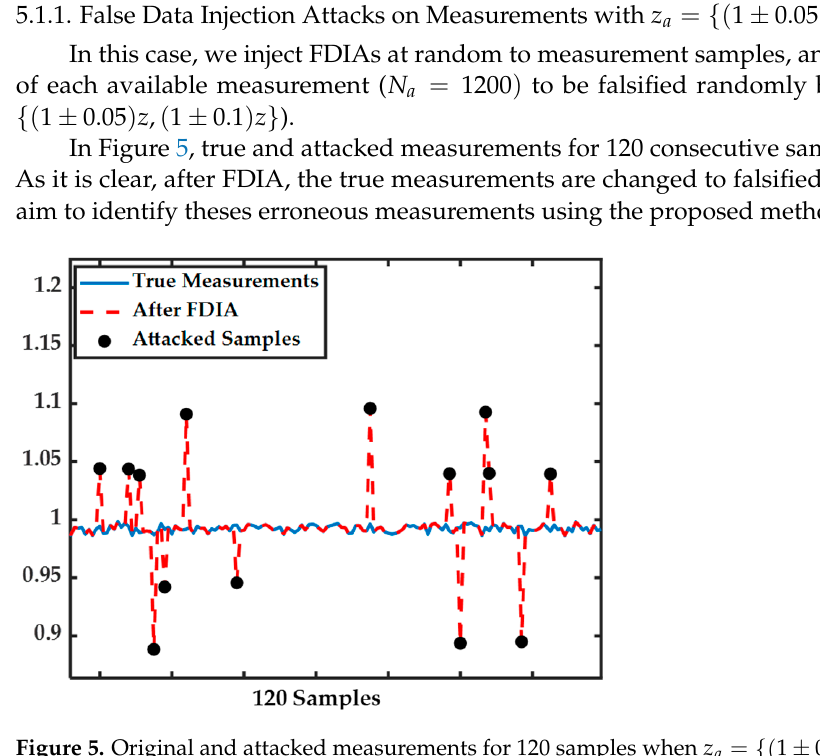
Figure 5. Original and attacked measurements for 120 samples when z a = { ( 1 ± 0.05 ) z , ( 1 ± 0.1 ) z } .